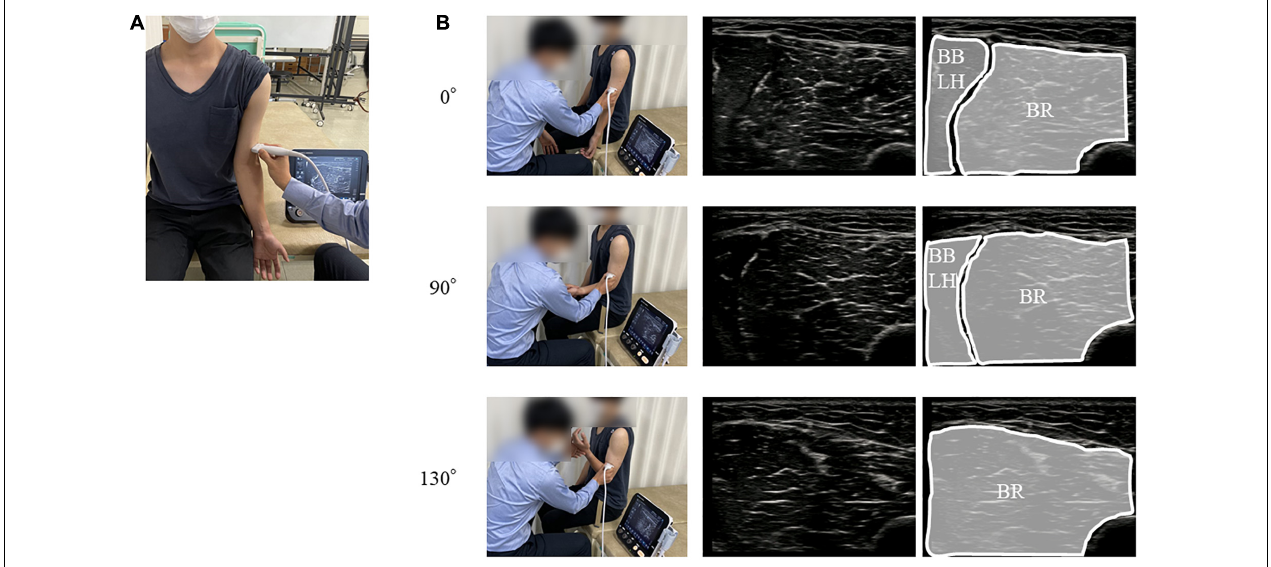
FIGURE 1 | Position and orientation of the ultrasound probe. (A) The position of probe for the BR. (B) The upper, middle, and lower panels represent the position of probe for the BR and ultrasound images of the BR at the 0 ◦ , 90 ◦ , and 130 ◦ elbow flexions, respectively. BR, brachialis muscle.